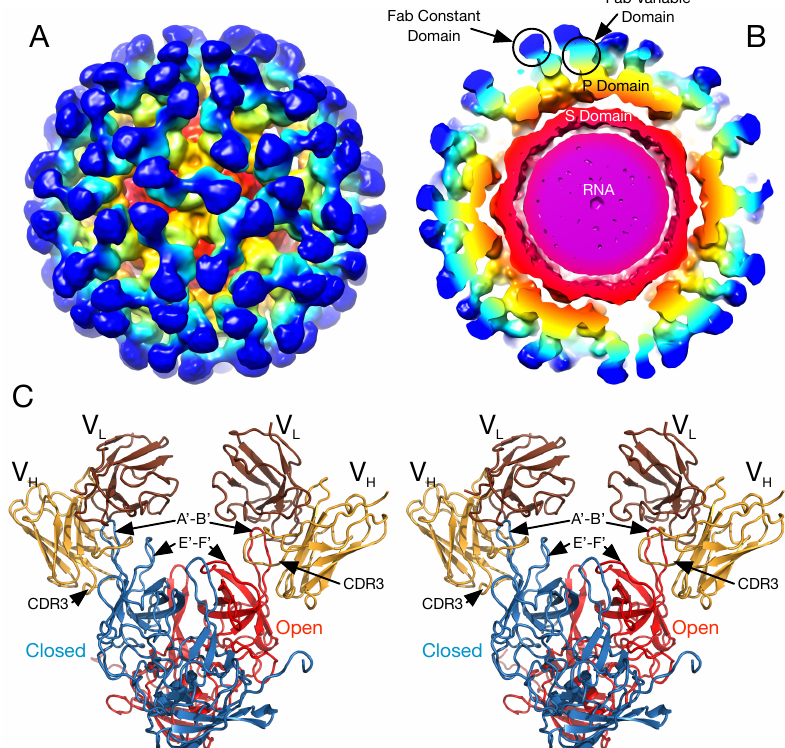
Figure 6. Pseudo atomic structure of MNV complexed with neutralizing antibody 2D3. Panel A shows the structure of MNV complexed with Fab fragments of 2D3 and panel B shows the same structure as a slice along the midsection. The surfaces are colored according to the distance from the center of the particle. As noted, the shell domain is orange, the P domain is yellow, the Fab variable domain is cyan, and the constant domain is blue. Note the large gap between the shell and P domain and that the Fab binds to the very top of the P domain. Panel C is a stereo diagram of the pseudo atomic model of the 2D3/MNV complex. The open and closed conformations of the P domain is shown in red and blue, respectively. The heavy chain variable and the light variable domains are shown in yellow and brown, respectively. Note that the CDR3 loop of the heavy chain fits into the cleft between the A’-B’ and E’-F’ loops in the open conformation but completely overlaps the E’-F’ loop in the closed conformation, making it unlikely that 2D3 can bind to the closed conformation. Figure adapted from